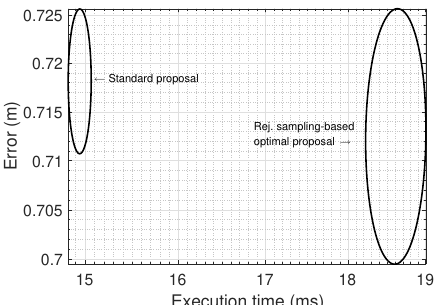
Figure 9. Execution time and average pose tracking error for two different PF algorithms. Ellipses represent 95% confidence interval as reconstructed from data of 25 repetitions of the same pose tracking experiment with different random seeds. Point cloud decimation was set to 100 in both algorithms. See Section 6.4 in the text for a discussion.